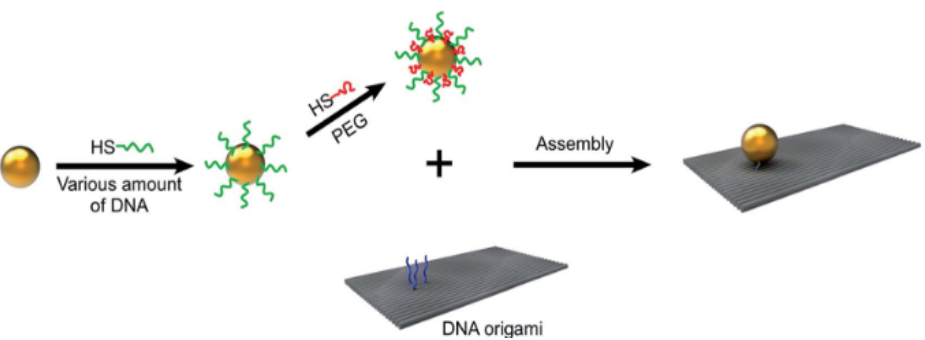
Figure 16. AuNPs are functionalized in two stages: first with DNA/PEG polymers comprising variable amounts of DNA, and then with rectangular DNA origami. Adapted from Ref. [130], copyright 2017, with permission from The Royal Society of Chemistry.